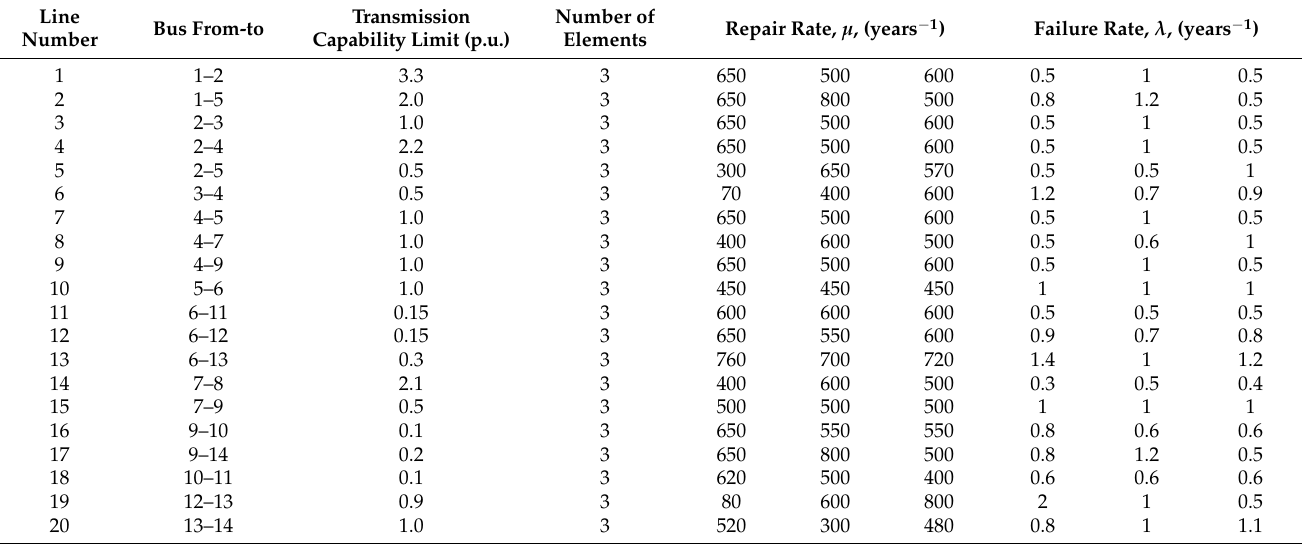
Table 3. Statistical parameters of lines/transformers of IEEE-14 system.